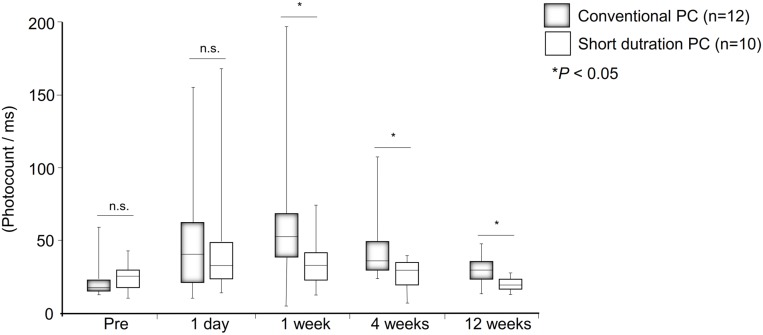
Laser flare cell values before, and at 1 day, 1 week, 4 week, and 12 weeks postoperatively for the short pulse duration PC group and the conventional PC group.The laser flare cell values were significantly lower in the short pulse duration PC group than in the conventional PC group at 1 week, 4 weeks and 12 weeks (P <0.05). Data are presented as Box–whisker plot and analyzed with Unpaired t tests.